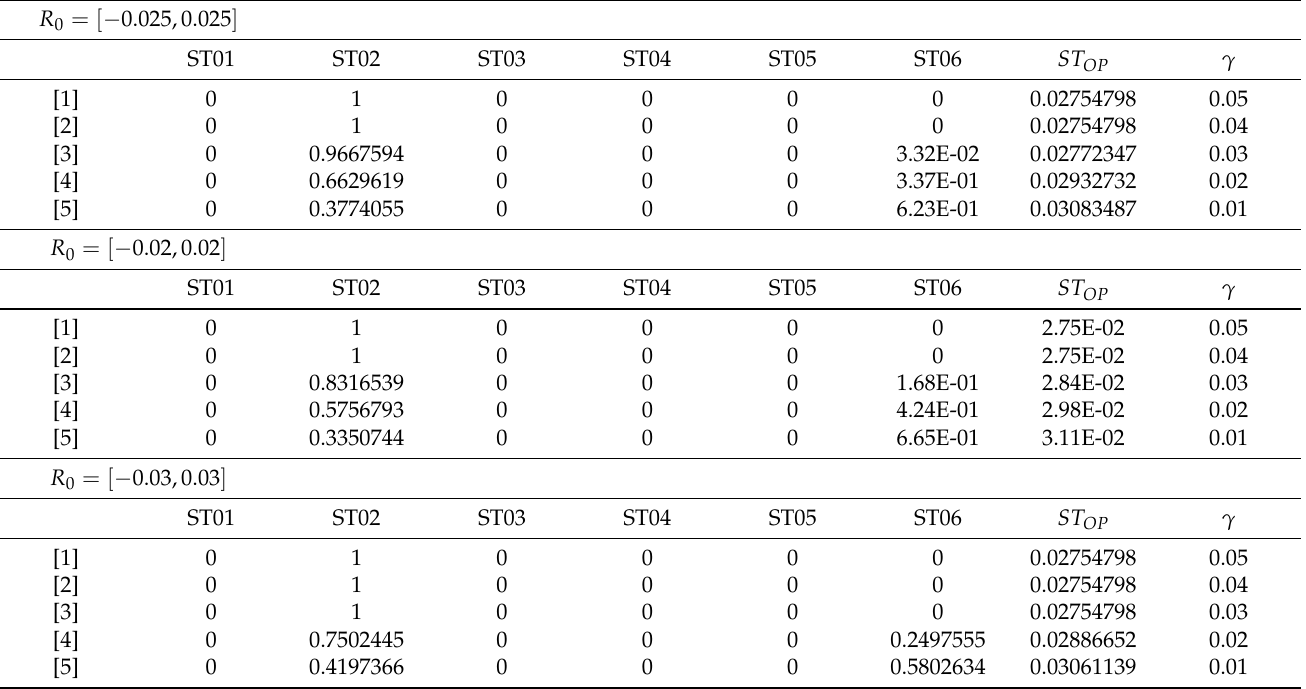
Table 12. Solution of Model 2, data from international